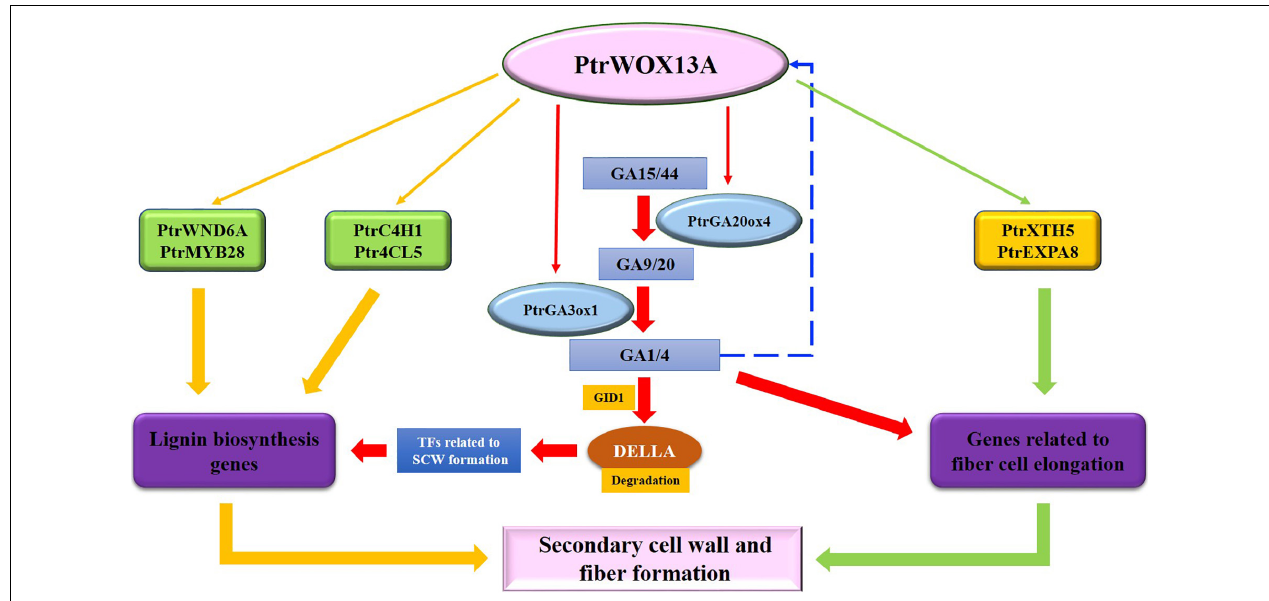
FIGURE 9 | Postulated regulatory model of the PtrWOX13A regulatory